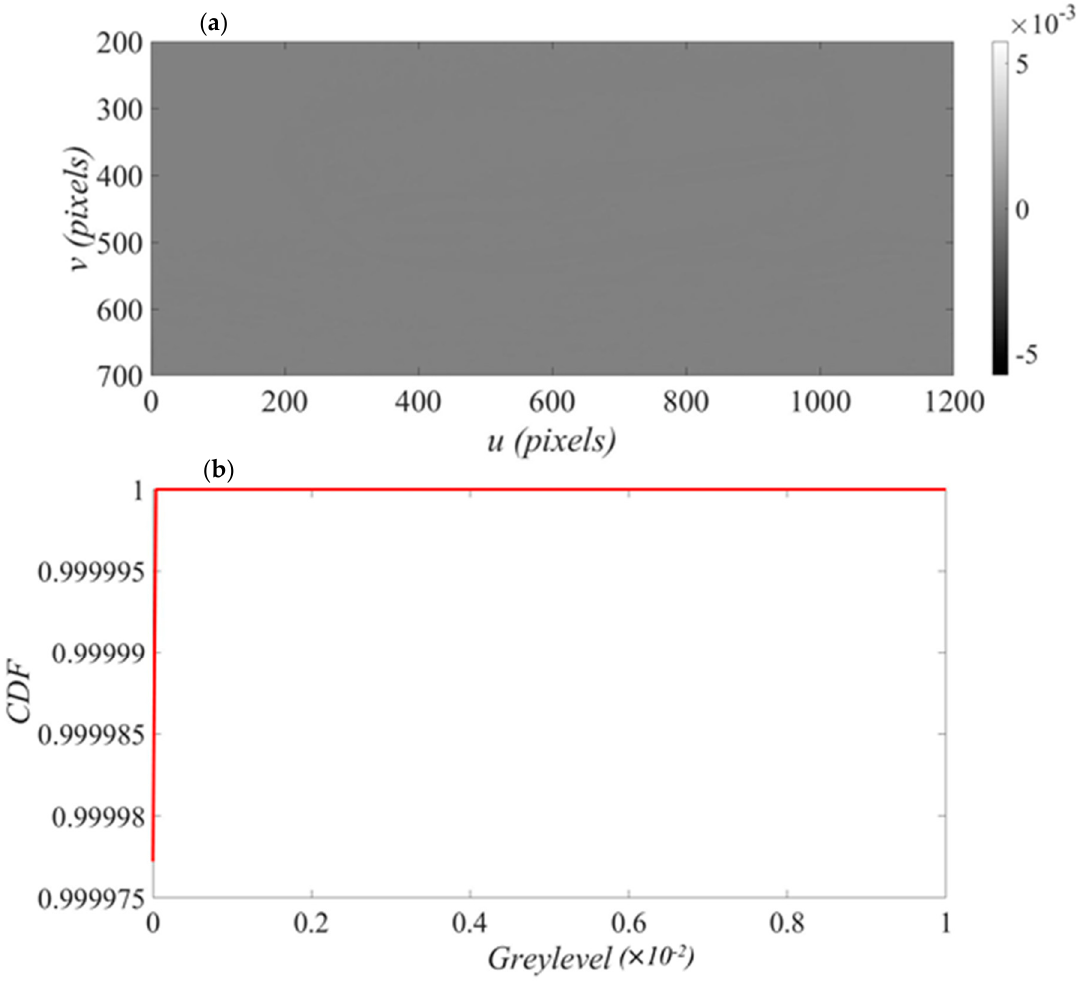
Figure 25. ( a ) Harris corner strength of the target object; and ( b ) CDF plot for the positive Harris corner strength in the underwater environment (white indicates positive values, whereas black signifies negative values).